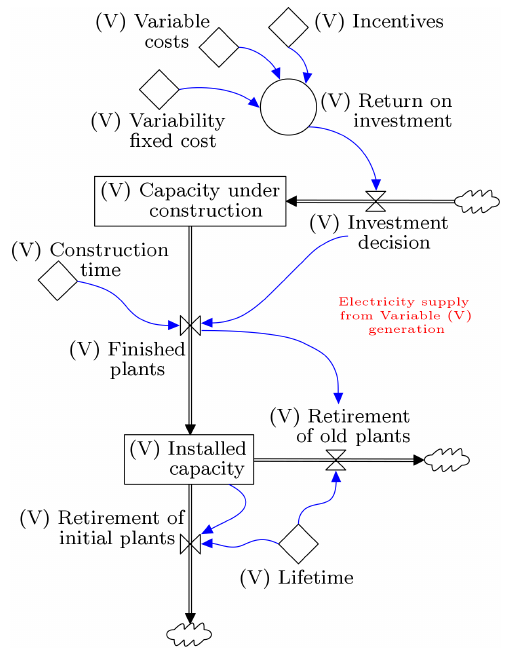
Figure 3. Electricity supply from hydroelectricity ( V ) generation as in [13,14]. Variability fixed cost = fixed cost. Reprinted with the permission of Reference [13]. Copyright 2018